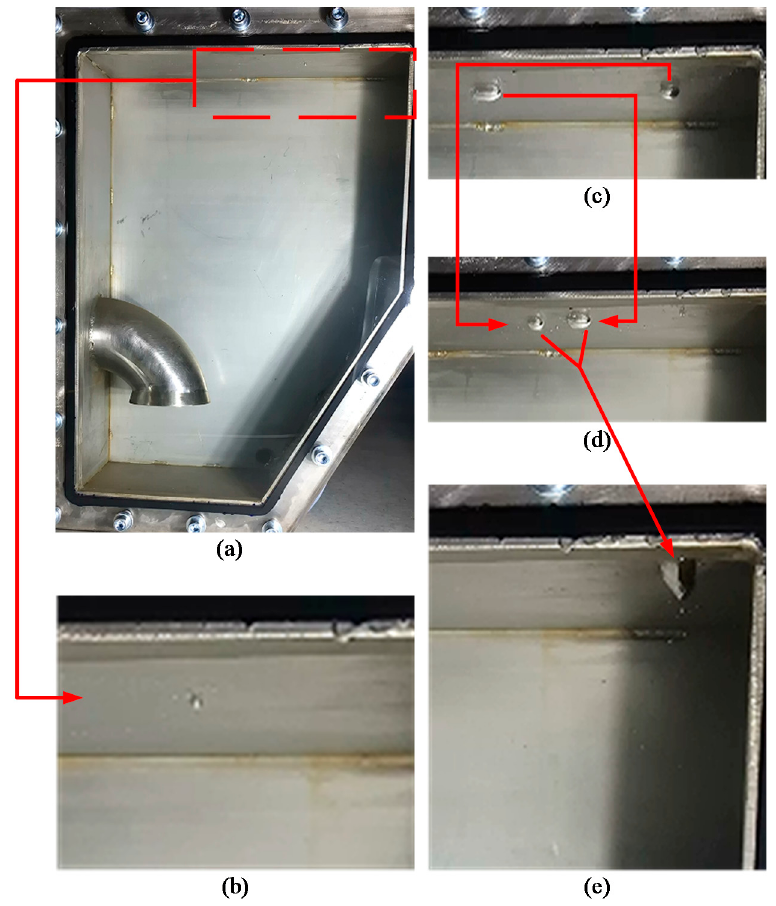
Figure 12. Vortex in the secondary pump intake. ( a ) The observation area of the top wall of the secondary pump intake, ( b – e ) evolution of vortex pulling serial air bubbles on the top wall of the secondary pump intake.